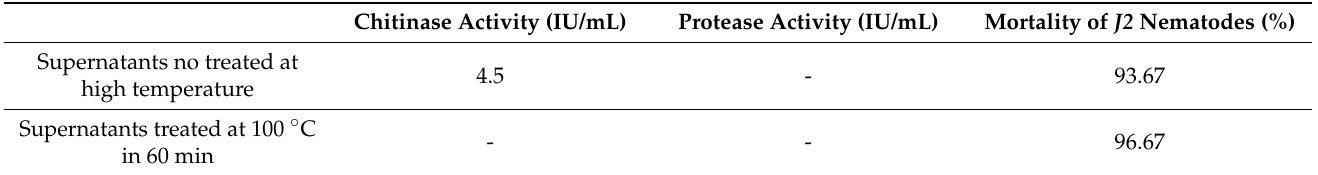
Table 1. Bioactivities of supernatants produced by B. velezensis RB.EK7 before and after high- temperature